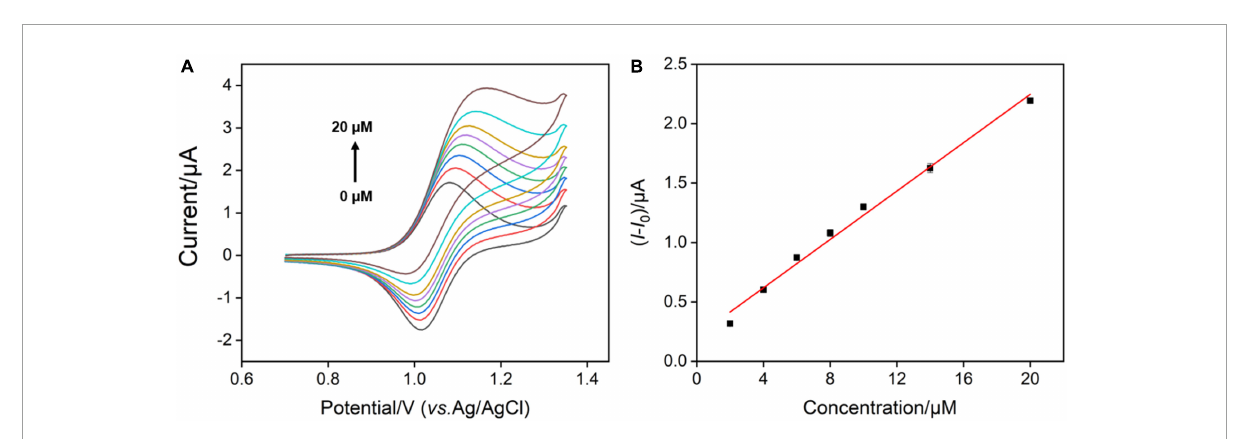
FIGURE8 (A) CV curves measured by VMSF/ITO after adding different concentrations of ganciclovir to the 0.1 M PBS (pH 7.0) containing 0.1 µ M Ru(bpy) 32 + . (B) The linear relationship between anodic peak current variation and concentration of